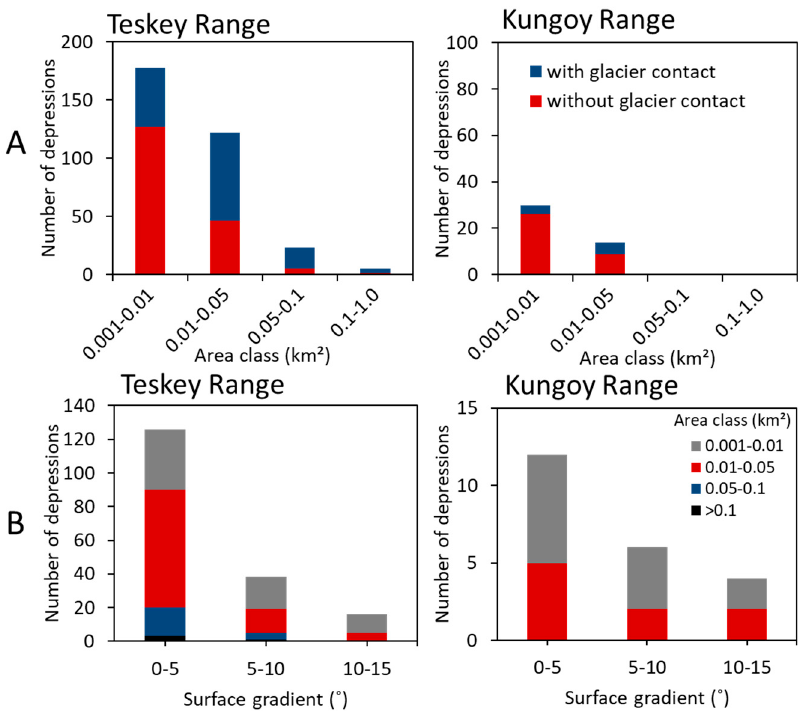
Figure 6. Characteristics of depressions in the Teskey and Kungoy Ranges. ( A ) The number of depressions with and without glacier contact of the various area classes. ( B ) The number of depressions of various surface-gradient ranges for each area class.